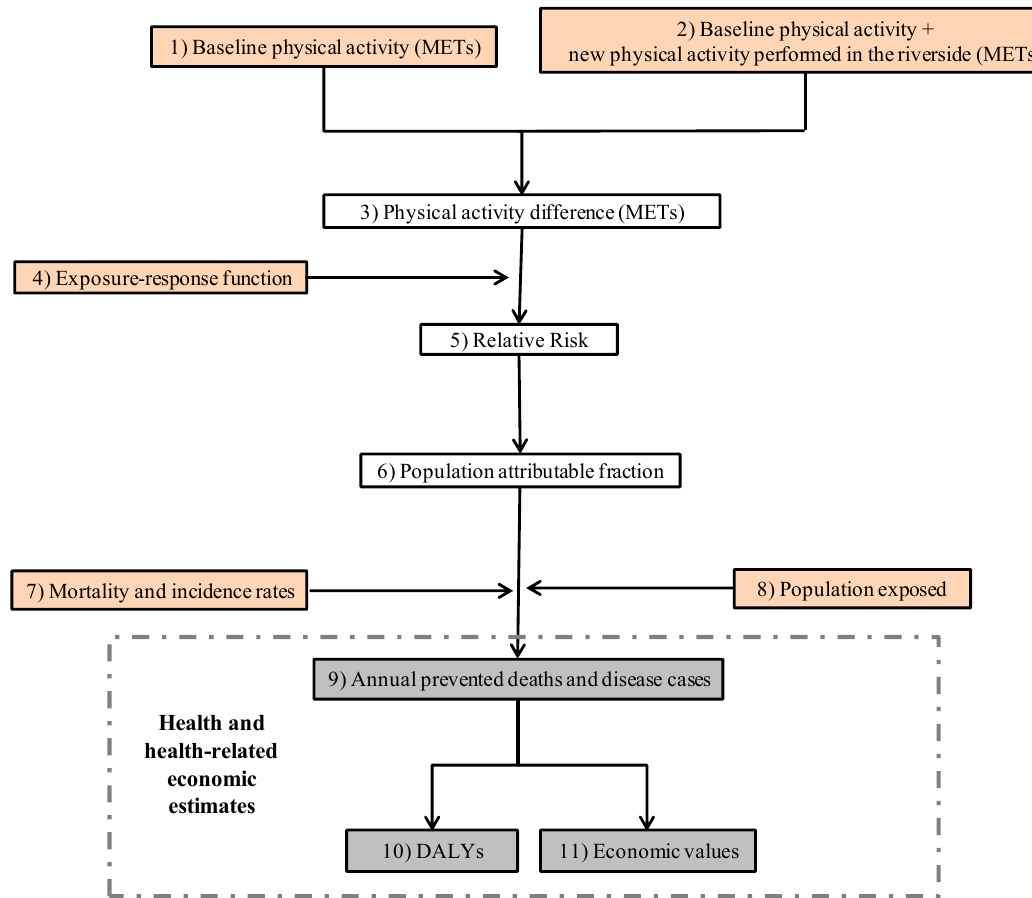
Figure 2. Methodological approach of the “Blue Active Tool.” In orange, the input data used in this